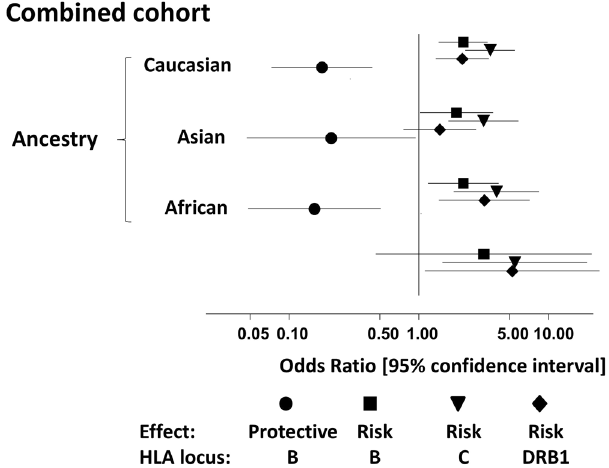
Figure 3. Relative effects of predisposing and protective HLA clusters on cutaneous NVP HSR risk. Odds ratios have been estimated from multivariate logistic regression modelling with adjustment for ethnicity.